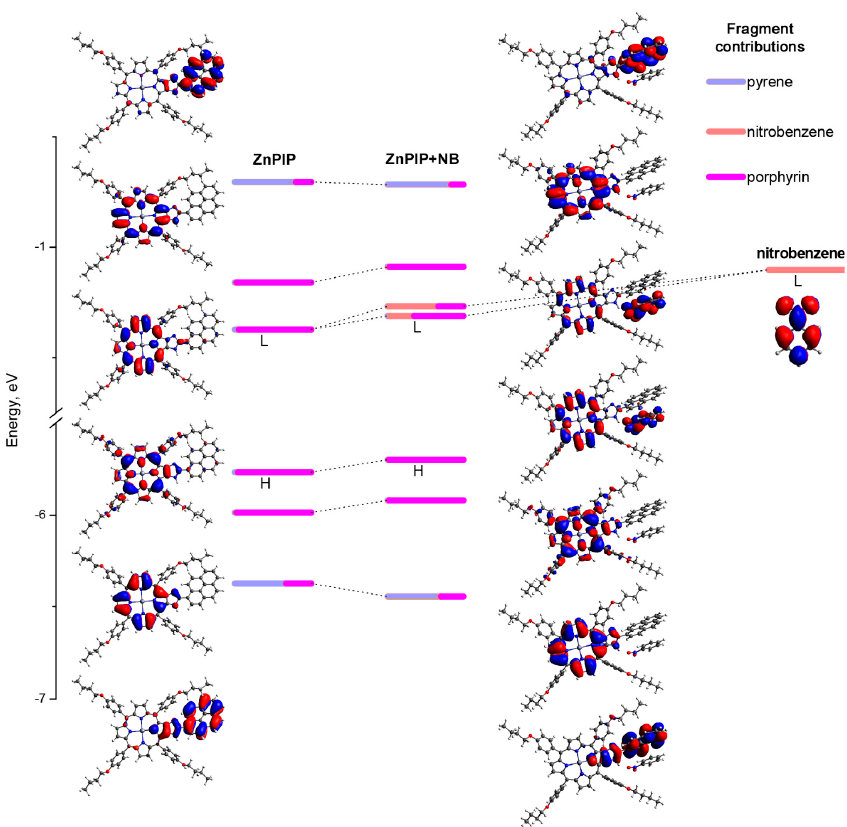
Figure 11. Diagram of frontier orbitals of ZnPIP , ZnPIP + NB and nitrobenzene. Energies and sym- metries of orbitals were calculated at CAM-B3LYP/6-31G(d)+CPCM(toluene) level of theory for r 2 SCAN-3c optimized geometries. The bars, corresponding to positions of certain orbitals on the energy scale, show the partitioning of orbitals between imidazoporphyrin, pyrene and nitrobenzene fragments.